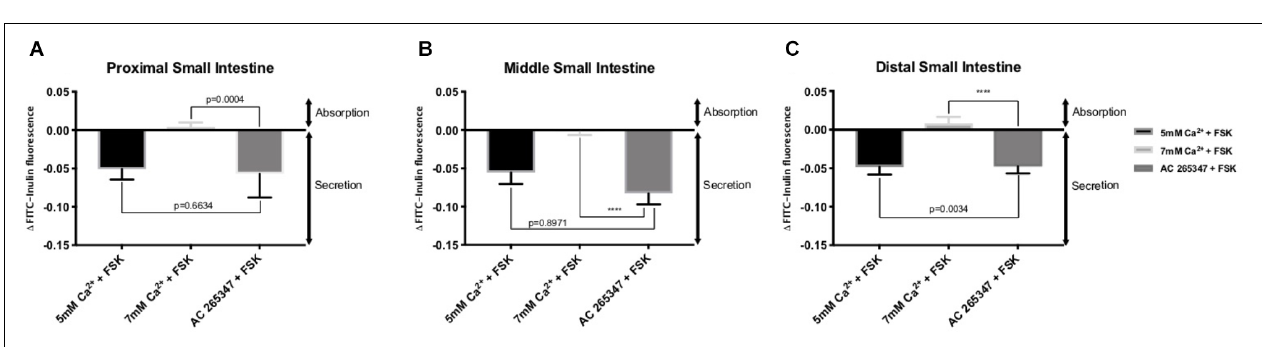
FIGURE 4 | Comparison of the effect of intraluminal [Ca 2 + ] and 2 µ M AC-265347 in reducing FSK-induced fluid secretion in the: (A) Proximal small intestine (B) Middle small intestine (C) Distal small intestine. P value < 0.0001 is represented by ∗∗∗∗